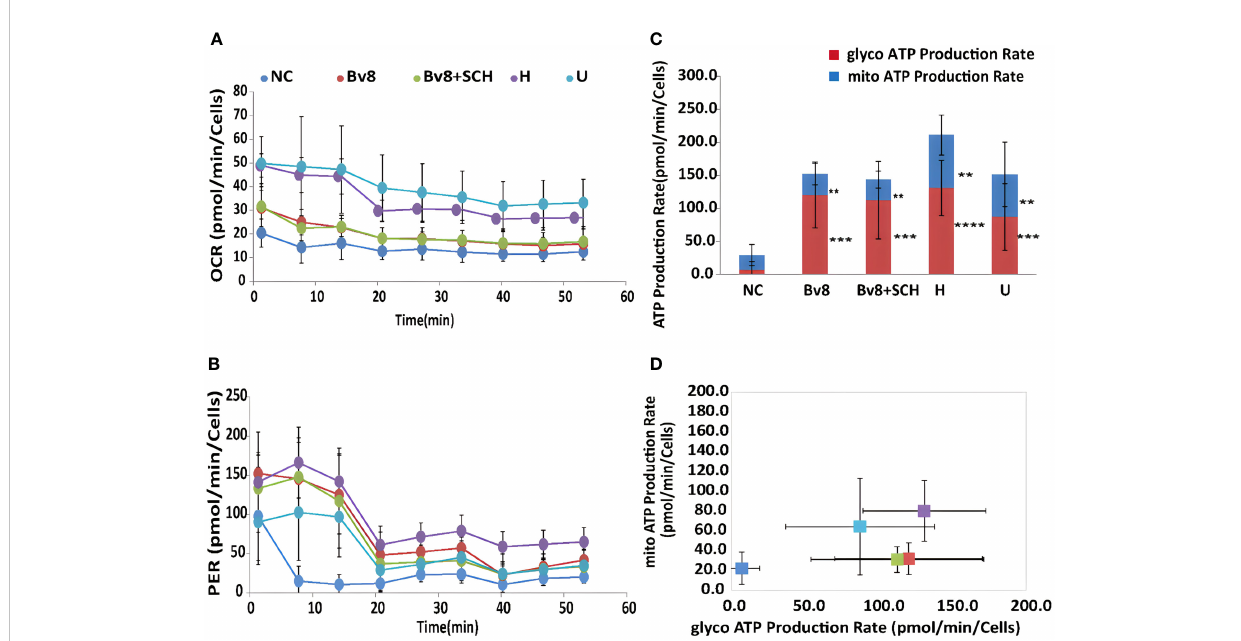
FIGURE 6 Bv8 or co-culturing with myeloid cells increased energy consumption of Caco-2 cells. (A) Real-time ATP production rate during mitochondrial respiration for 60 minutes and data was presented as oxygen consumption rate (OCR, pmol/min/cells) of Caco-2 cells. Caco-2 cells were treated with 1 nM of Bv8 (red), 500 nM SCH + 1 nM Bv8 (green), Hl60 cell (purple) and U937 cells (light blue) prior to ATP assay. (B) Real-time ATP production rate during glycolysis for 60 minutes and data was presented as proton ef fl ux rate (PER, pmol/min/cells) of Caco-2 cells. (C, D) Both glycolytic ATP production rate and mitochondrial ATP production rate of Caco-2 cells were signi fi cantly increased after all treatment. Caco-2 cells were treated with 1 nM of Bv8 (red), 500 nM SCH + 1 nM Bv8 (green), Hl60 cell (purple) and U937 cells (light blue) prior to ATP assay. All data were presented as mean ± SD. Two-way ANOVA was used for statistical analysis followed by Student-Newman-Keuls test **p<0.01, ***p<0.001, ****p<0.0001. NC, naïve control; H, co-cultured with HL60 cells; U, co-cultured with U937 cells. n refers to the number of independent